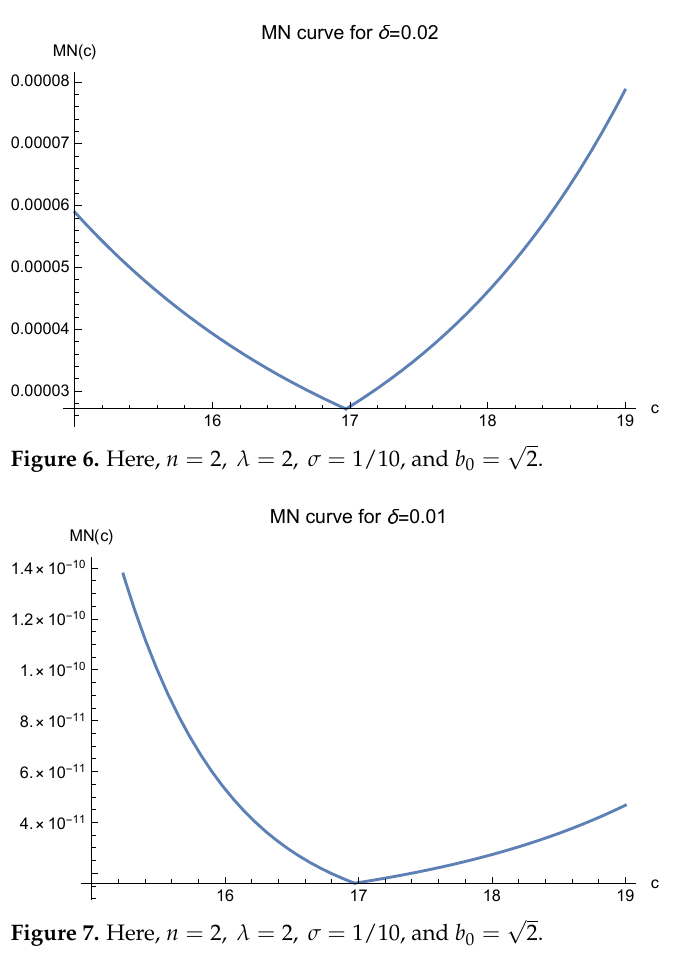
Figure 7. Here, n = 2, λ = 2, σ = 1/10, and b 0 =